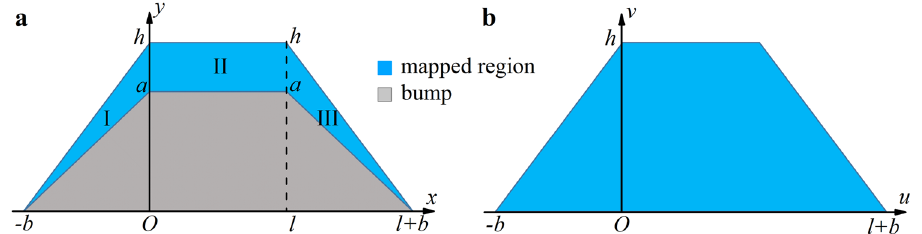
Figure 1. Schematic of the transformation for the carpet cloak. ( a ) The physical space whose coordinate frame is ( x , y , z ). The cloaked bump is defined by the grey trapezoid. The carpet cloak (blue region) is separated into two triangles (region I and region III) and one rectangle (region II). ( b ) The virtual space whose coordinate frame is ( u , v , w ). The blue region in the physical space ( a ) is mapped to the blue trapezoid in the virtual space ( b ) by the linear